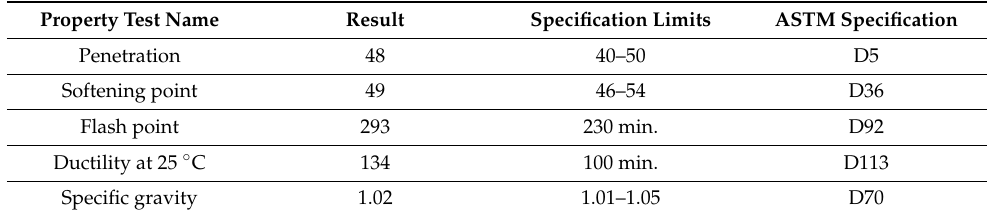
Table 1. Physical characteristics of the asphalt